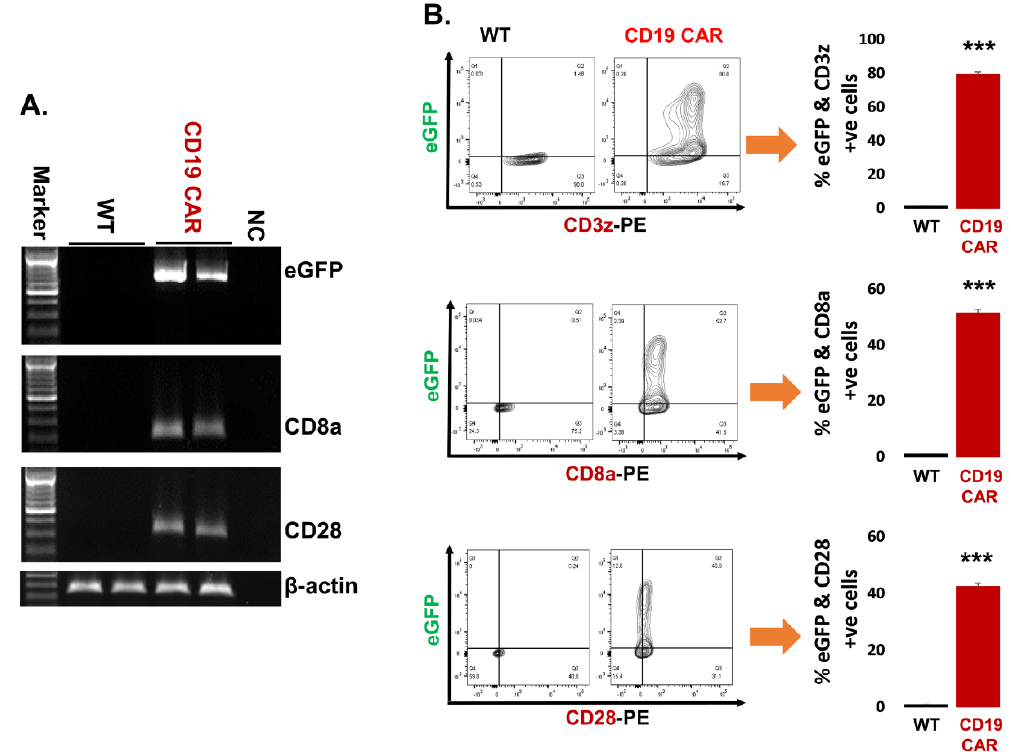
Figure 2. Confirmation of CD19 CAR plasmid into the transfected producer cell line. ( A ) Agarose gel demonstrating cellular mRNA expression (eGFP, CD8a, and CD28) in CD19 CAR plasmid transfected HEK293T cells and control non- transfected cells (WT-control). The β -actin band is same for each gene of interest because same sample/cDNA was used for PCR amplification of eGFP, CD8a, and CD28. ( B ) Protein expression by flow cytometry (contour plot) demonstrating surface protein expression of CD3z, CD8a, and CD28 co-localized with eGFP expression in CD19 CAR plasmid transfected HEK293T cells (CD19 CAR) and non-transfected cells (WT-control). Bar graph is representation of the three replicates. p -value (*** p < 0.001). This is a representation of cellular CD3z, CD8a, and CD28